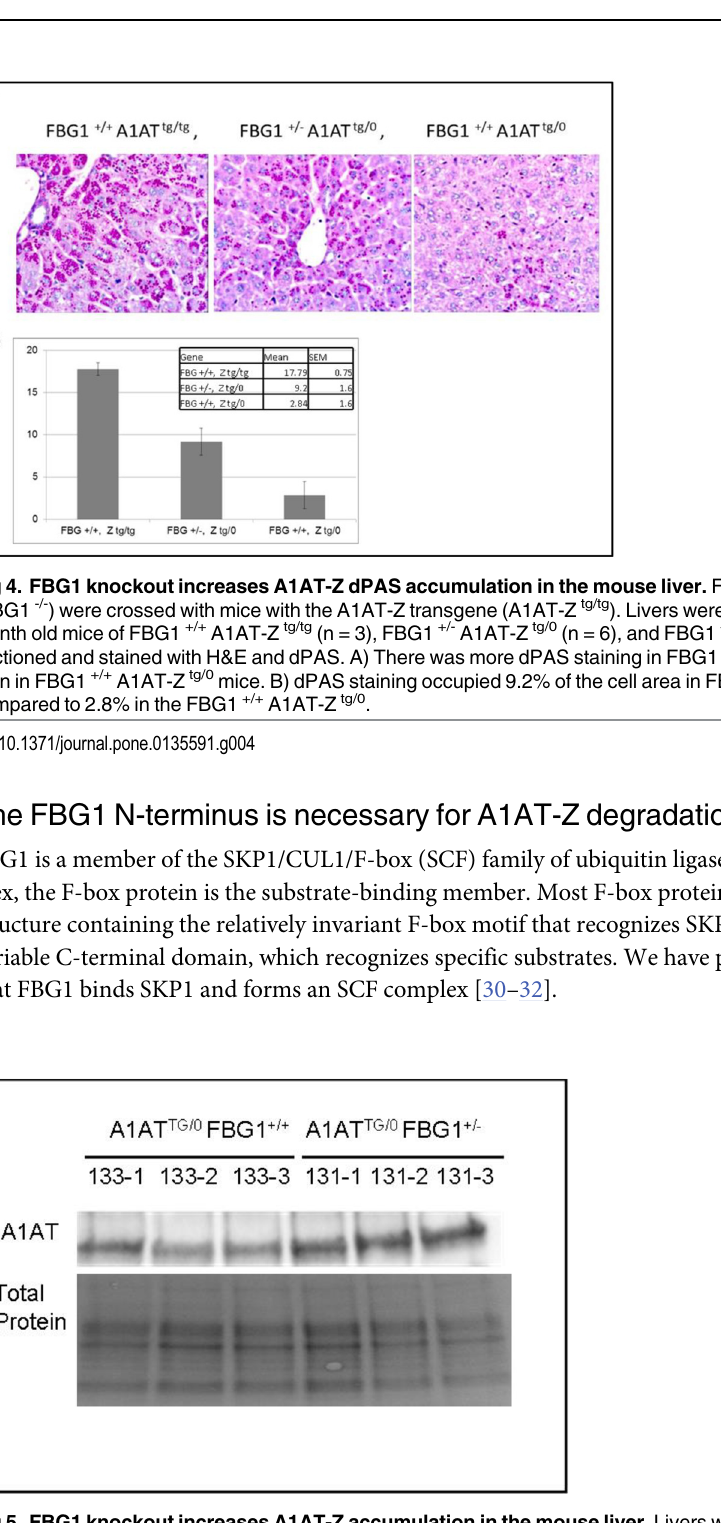
Fig 5. FBG1 knockout increases A1AT-Z accumulation in the mouse liver. Livers were harvested from 6-month-old FBG1 +/0 A1AT-Z tg/0 and FBG1 +/+ A1AT-Z tg/0 mice. Total cell lysates were separated on SDS-PAGE gels and probed with the following antibodies against A1AT and stained for total protein (loading control) (n = 3). Densitometry of A1AT normalized to loading control indicated a 1.8-fold increase in A1AT in FBG1 knockout liver (FBG1 +/0 A1AT-Z tg/0 ) compared to wild-type FBG1 liver (FBG1 +/+ A1AT-Z tg/0 ).